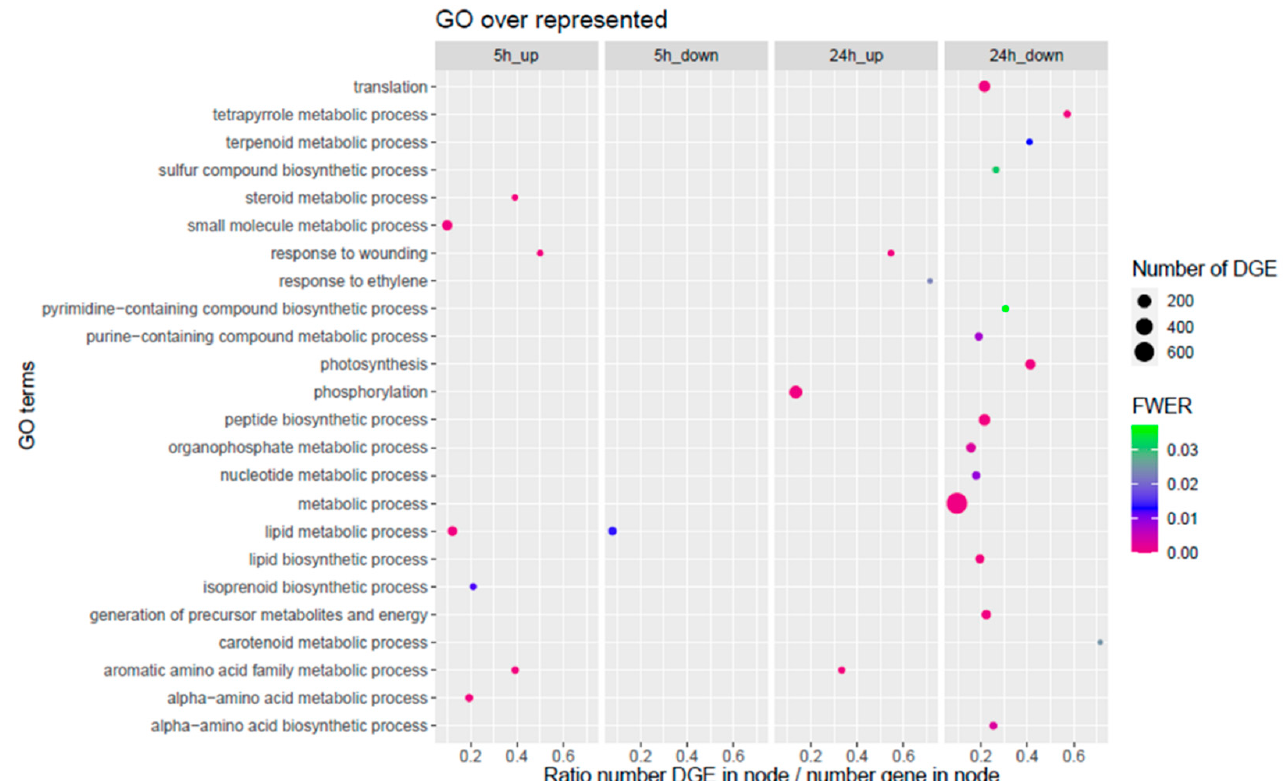
Figure 4. Gene ontology (GO) terms enrichment at p < 0.05 for up- and down-regulated genes after 5 h and 24 h of herbivory. The size of the circles represents the number of differentially expressed genes (DEG) in each GO category. The position of the circles represents the ratio between the number of DEGs in the GO category to the total number of genes associated to the GO category. The color of the circles represents the statistical significance.